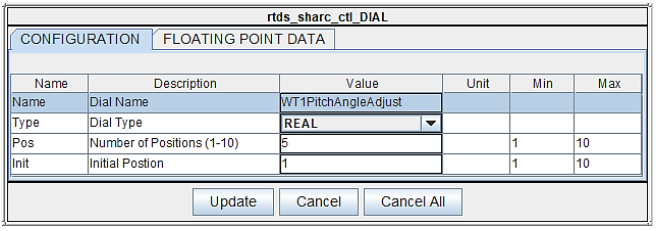
Figure 12. Wind turbine blade pitch angle adjustment slider settings.